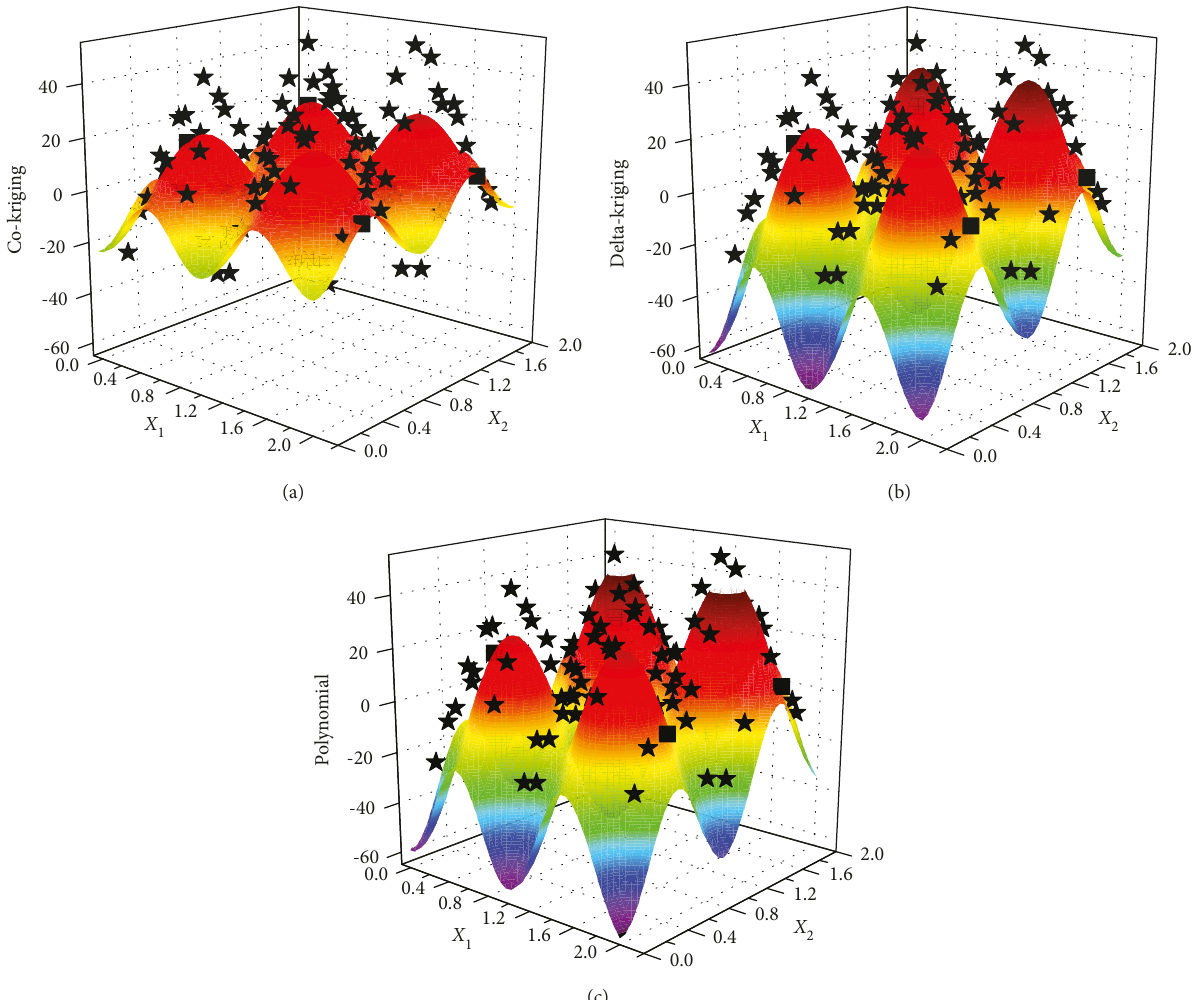
Figure 5: Results with 4 high LoF data points: (a) Co-Kriging method, (b) delta-Kriging method, and (c) polynomial